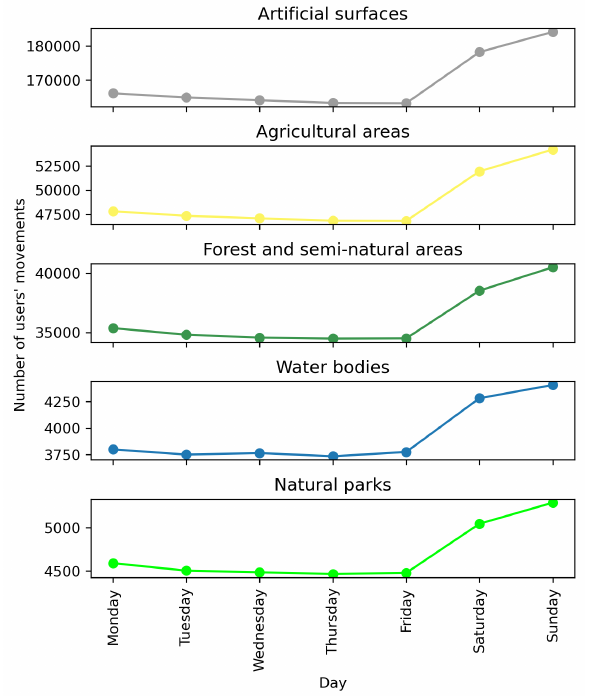
Figure 4. Average users’ movements by day of the week in each CLC class and natural park areas of the Insubria region.